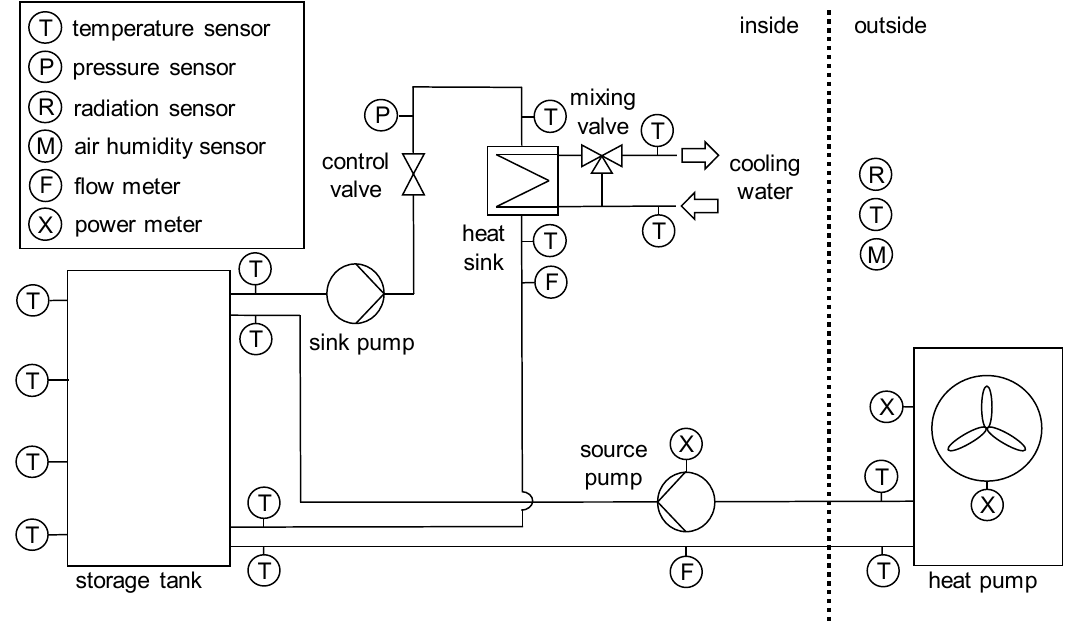
Figure 1. Setup of one test rig including the main components and the sensor equipment.